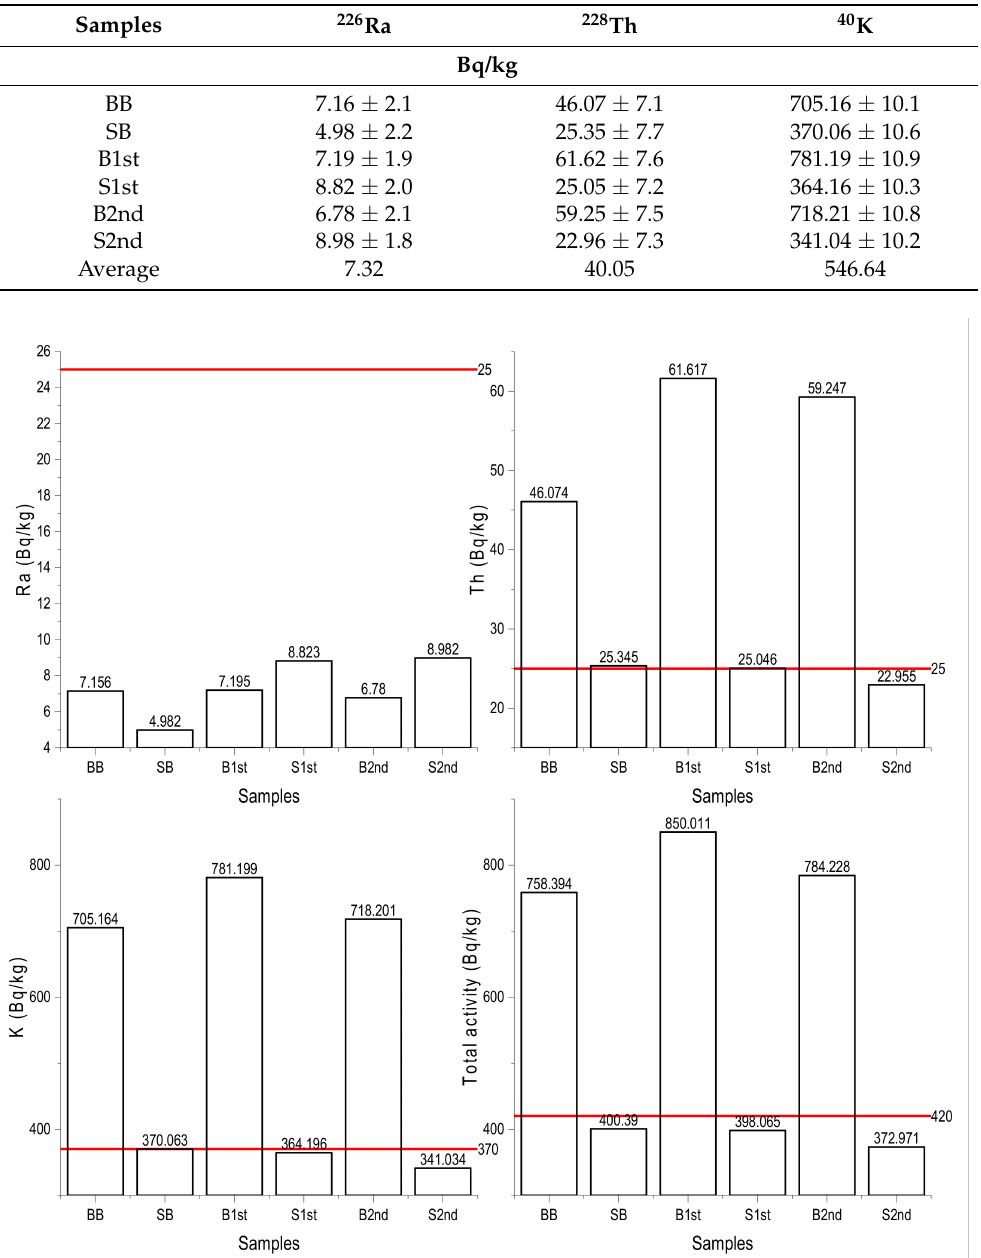
Table 4. Values of radionuclide activity concentrations in samples.